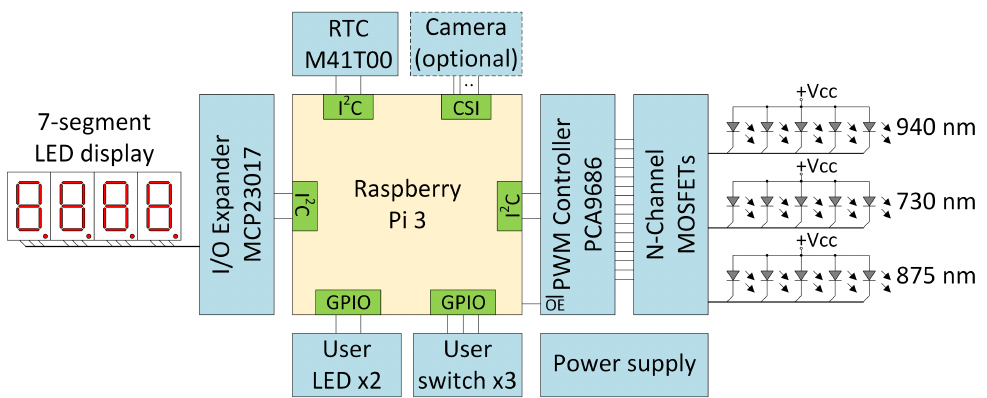
Figure 3. Block diagram of the proposed multi-wavelength biometric acquisition system. NIR LED diodes (940, 730, and 875 nm), 7-segment displays, PWM Controler PCA9686, and MOSFET transistors driver are attached externally. Connection with camera and RTC M41T00 is expected in a future stand-alone version. It is not utilized in the current